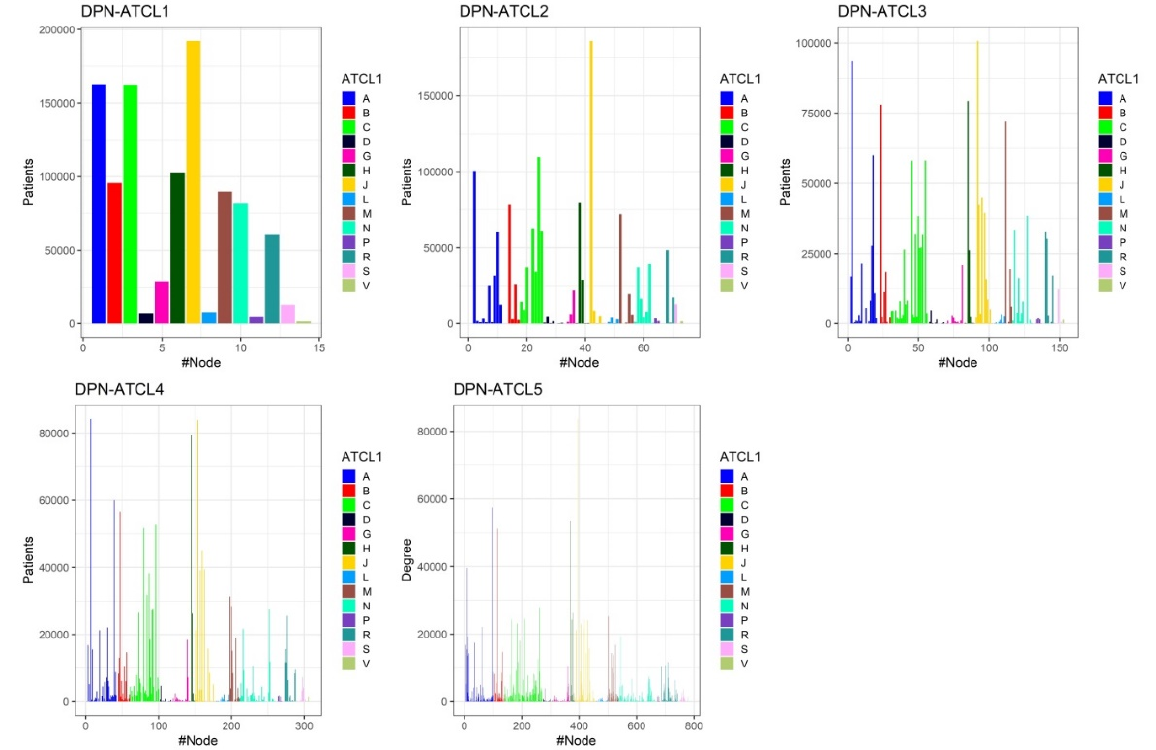
Figure A4. Number of patients prescribed with the ATC i . Data on drug prescription have been represented in the form of DPNs (ATCL1–ATCL5). The number of patients prescribed with each individual ATC was determined and is displayed in the bar plots. Nodes are coloured according to the 14 groups found at the first level of the ATC classification system.